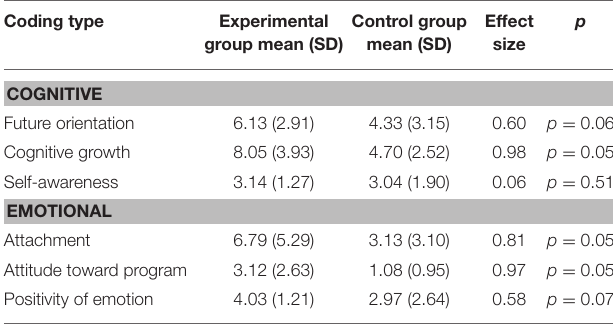
TABLE 3 | Comparisons of experimental vs. control group for journal content